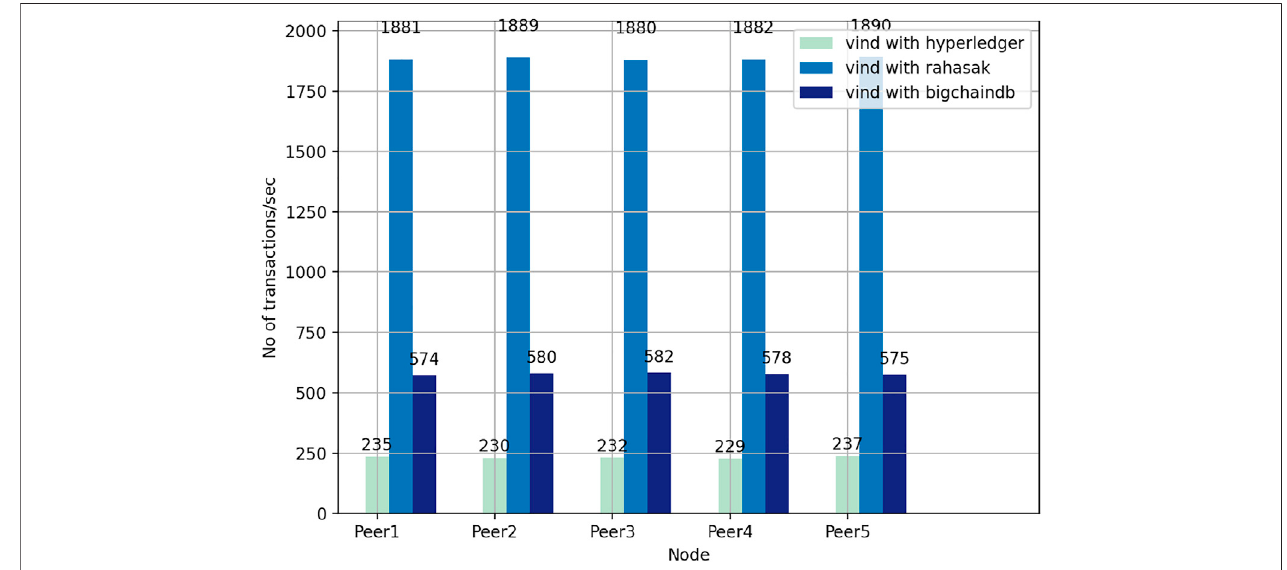
FIGURE 6 | Query transaction result of the Vind platform with different blockchain ledgers.